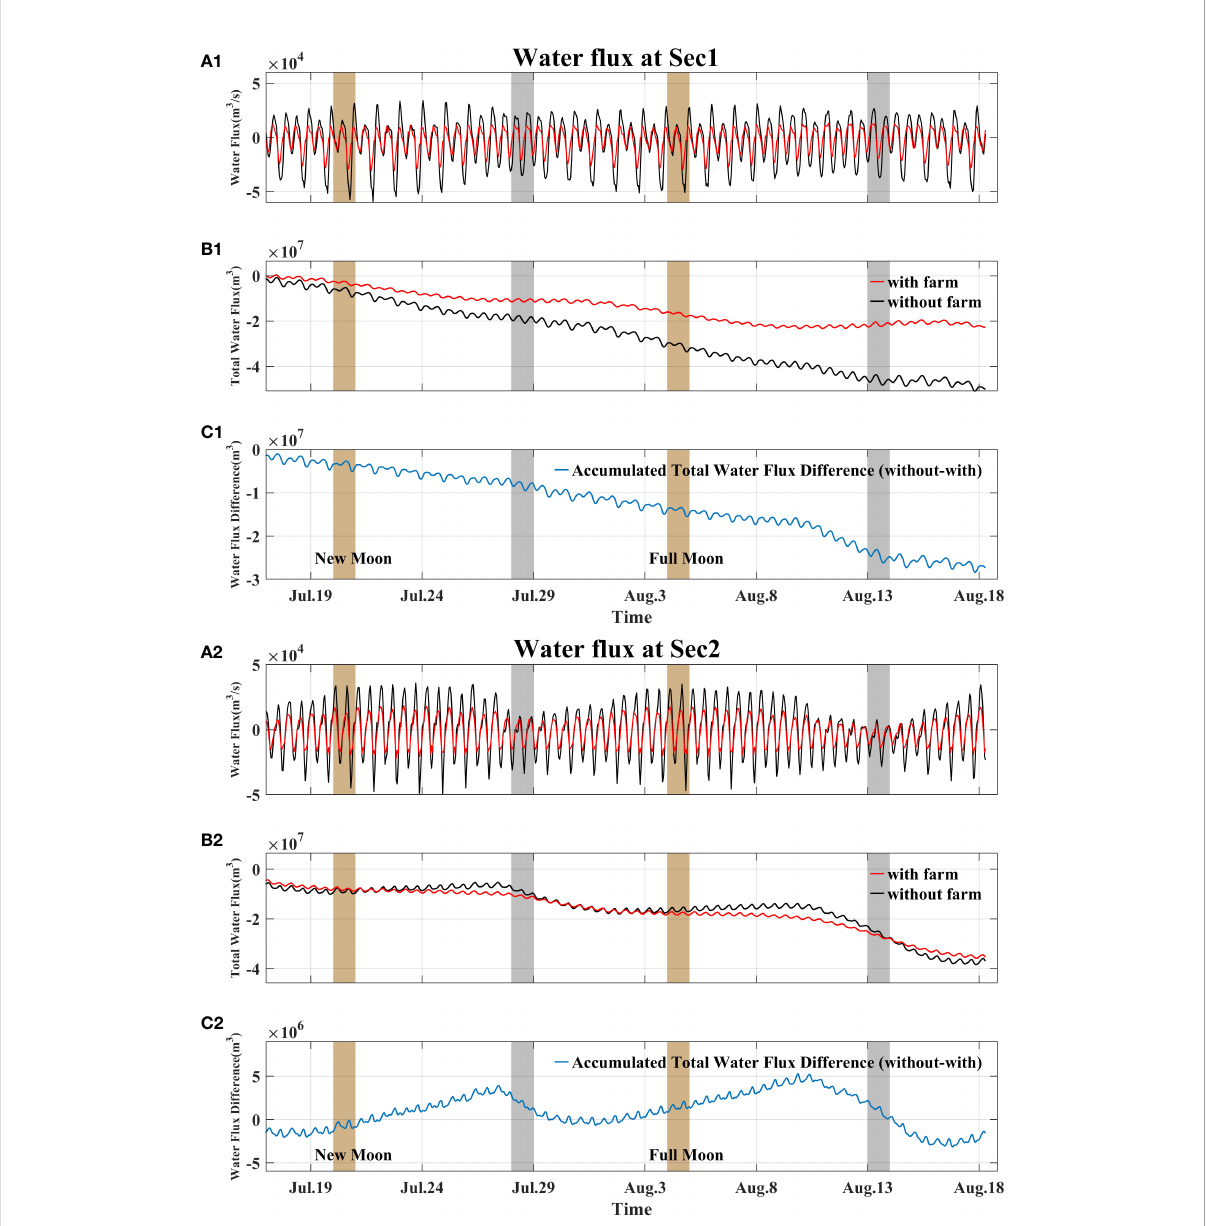
FIGURE 11 Water fl ux through Sec1 (A1-C1) and Sec2 (A2-C2). (A) water fl ux with (red) and without (black) farm. (B) accumulated total water fl ux with (red) and without (black) farm. (C) difference of total water fl ux with and without farm. The brown and grey box indicate time interval of 24 hours during spring and neap tide,